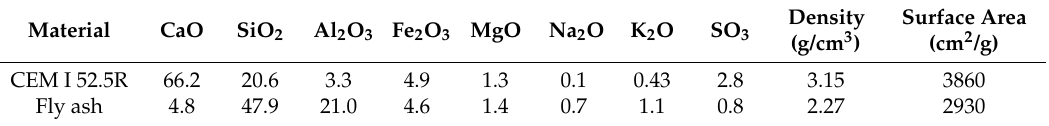
Table 1. Chemical and physical properties of the binder